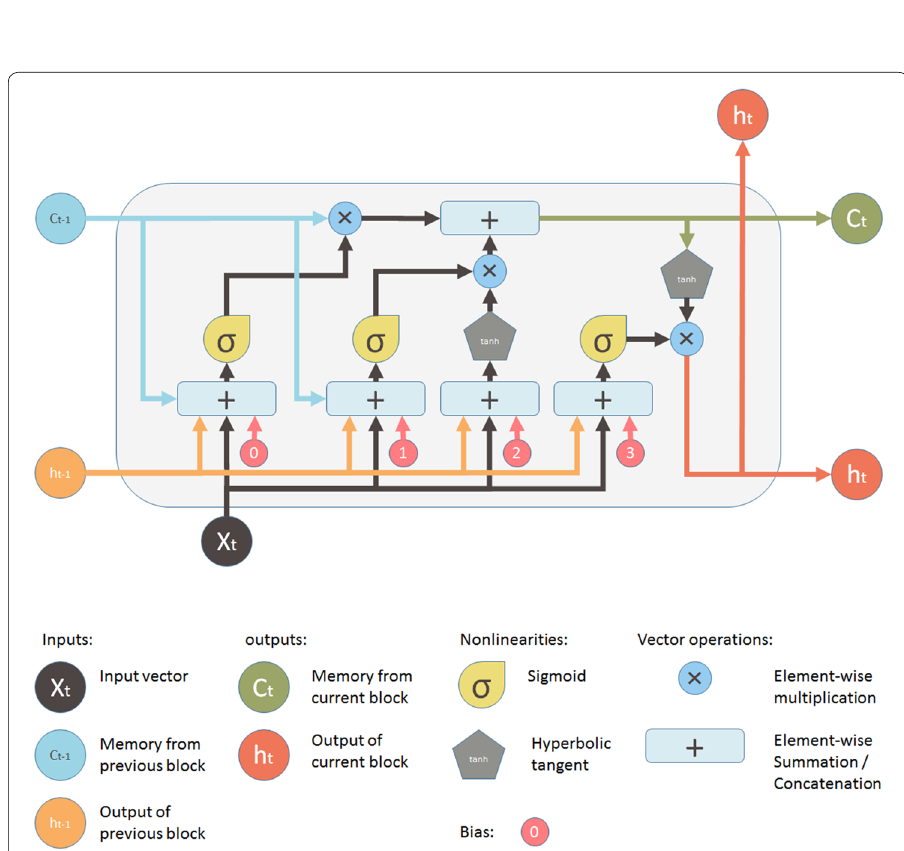
Fig. 4 LSTM cell [29]. Shows in details architecture of long short term memory